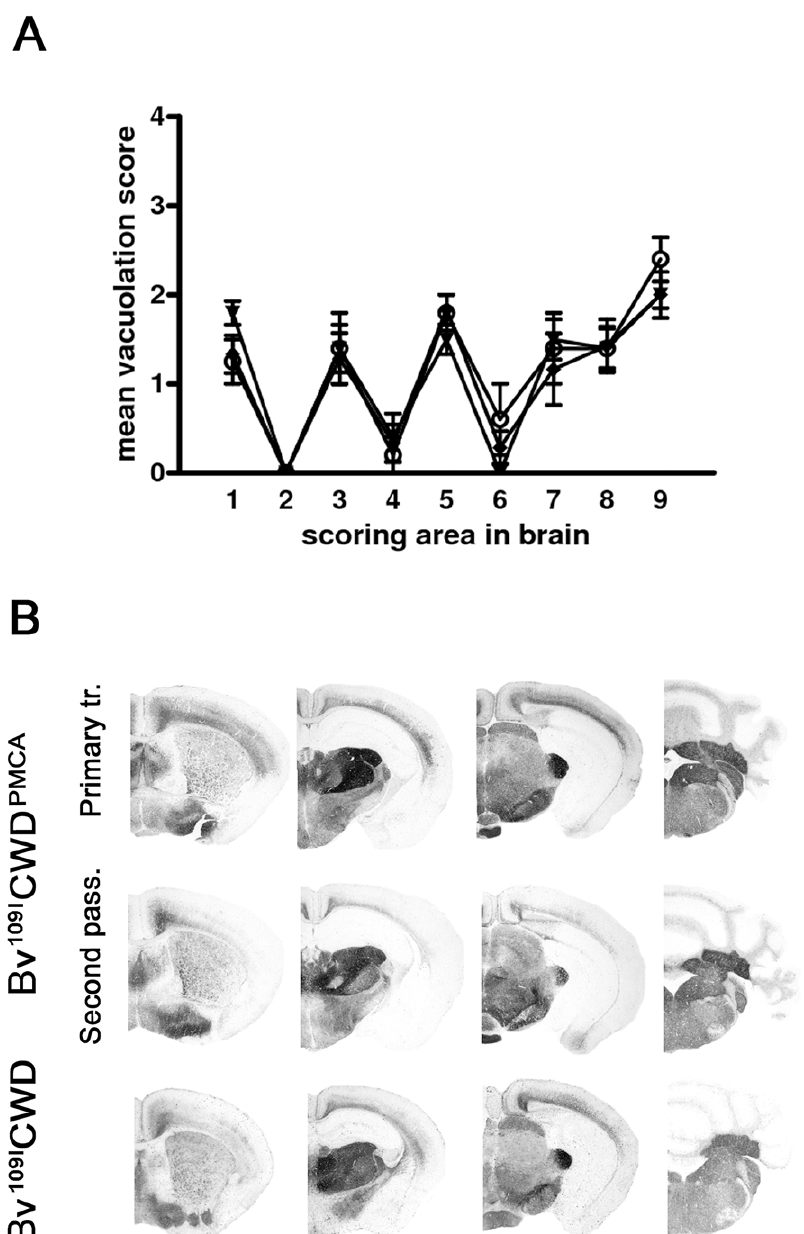
Figure 6. Biological properties of invitro -generated Bv 109I CWD (Bv 109I CWD PMCA ). A) Lesion profiles of Bv109I infected with Bv 109I CWD PMCA following primary transmission (open circles) and second passage (closed diamonds), compared with Bv109I infected with Bv 109I CWD (triangles). Brain-scoring positions are described in Figure 2. B) Regional distribution, by PET-blot with SAF84 mAb, of PrP res in Bv109I infected with Bv 109I CWD PMCA following primary transmission and second passage compared with the control group (Bv 109I CWD). Brain areas are as in Figure